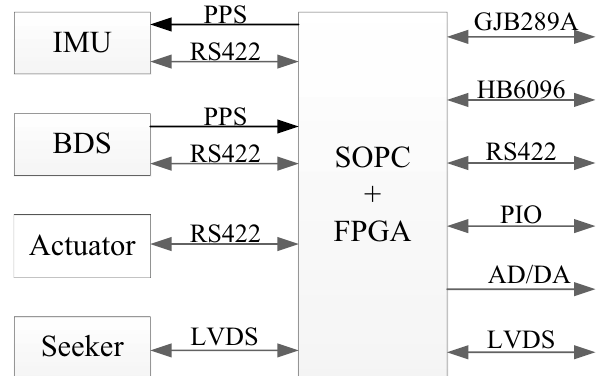
Figure 1. Composition of flight control components.